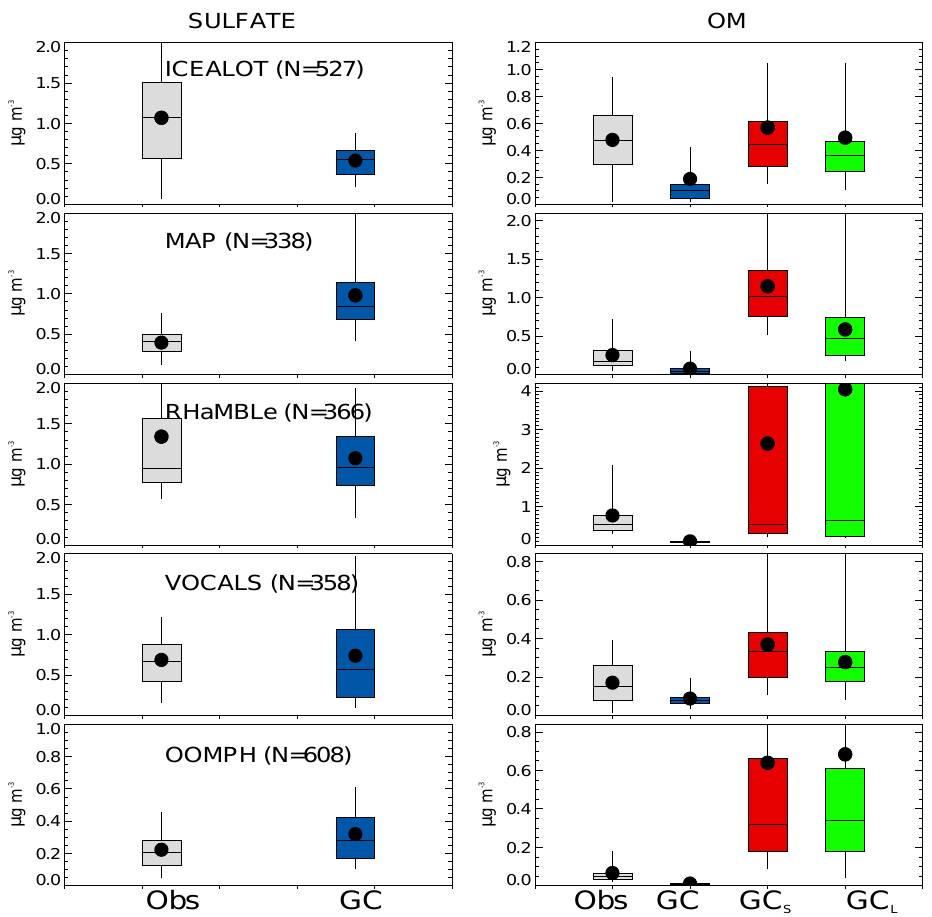
Fig. 5. Boxplots for measured and modeled surface sulfate (left) and OM (right) aerosol concentrations. Measurements are shown in gray. Modeled concentrations for the model simulation without marine OM (GC), with marine OM from Spracklen et al. (2008) (GC S ) and with marine OM from Langmann et al. (2008) (GC L ) are plotted in blue, red and green, respectively. Individual campaigns are shown on each row, with number of observations ( N ) given in inset. Only values within the y-axis range are shown. were available for two out of five campaigns studied